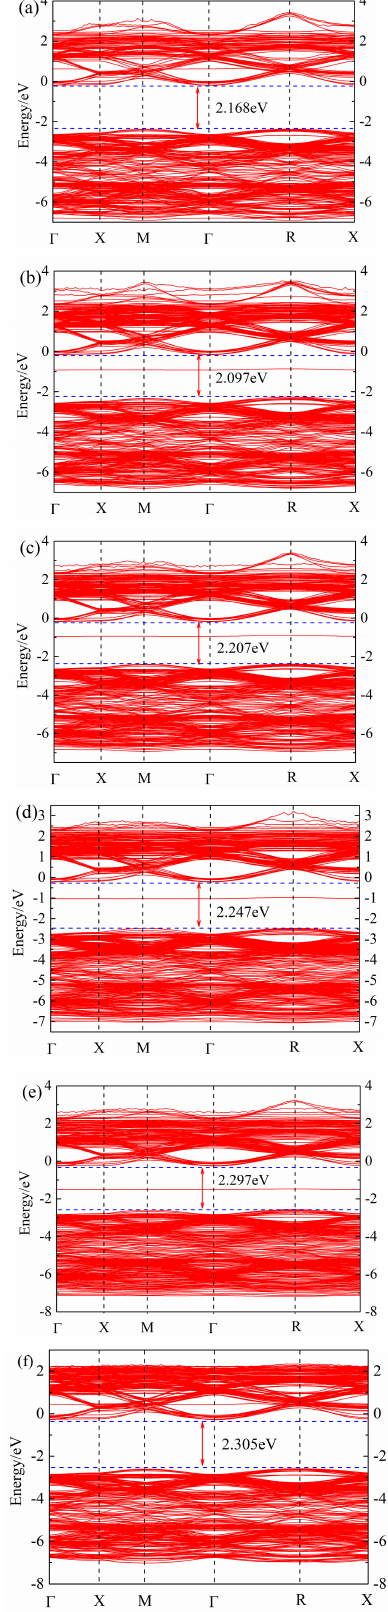
Figure 2. Band structure of (Sr 0.889-x La 0.111 Bi x )TiO 2.963. ( a ) Sr 0.889 La 0.111 TiO 2.963; ( b ) Sr 0.852 La 0.111 Bi 0.037 TiO